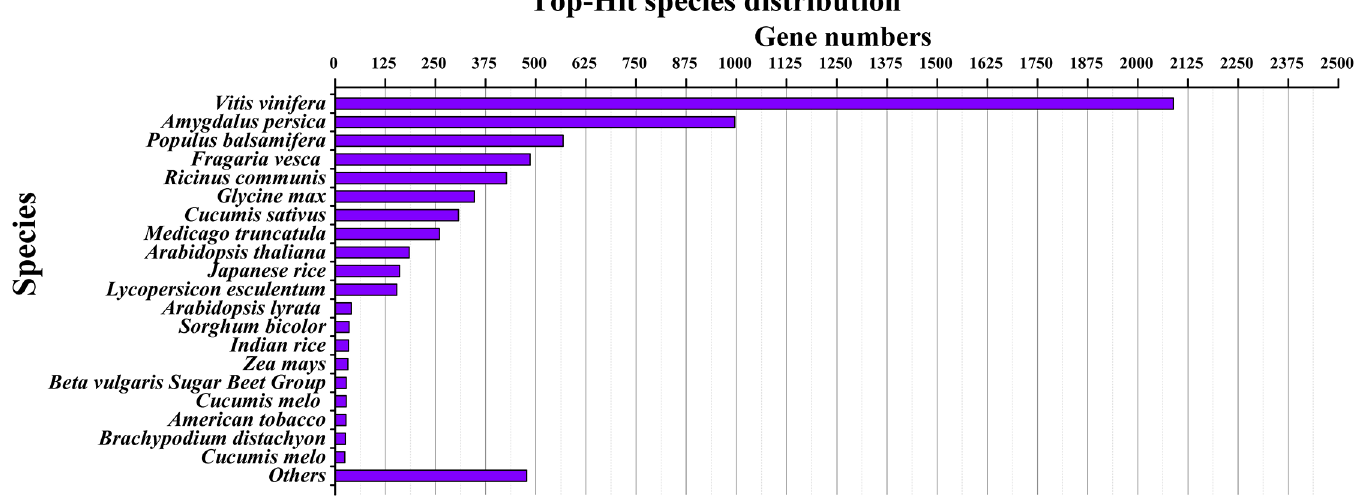
Fig 5. GO classifications of annotated contigs of M. rubra .